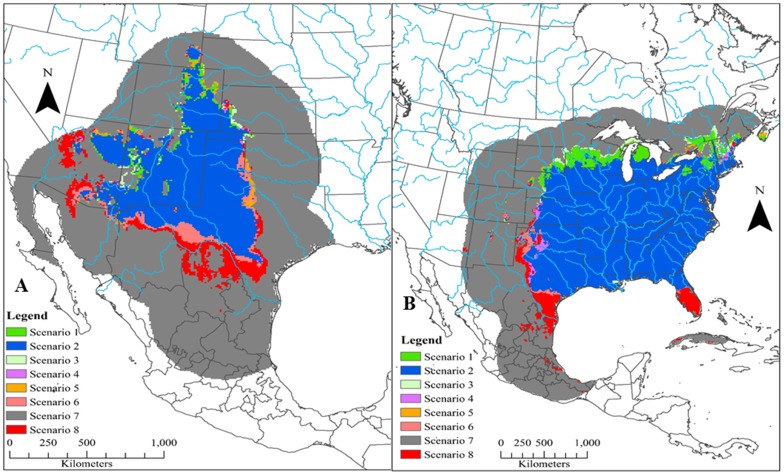
Future predicted changes in distributions of scaled quail (Callipepla squamata; a) and northern bobwhite (Colinus virginianus; b) projected to 2070 and based on ensemble forecasts (as estimated through Maxent) at 90% agreement.Major rivers of North America (blue lines) are included for geographic reference. Full descriptions for possible distribution conditions are given in Table 2. In short, distribution conditions represent: condition 1 (distribution expansion from current to 2050 and remaining suitable from 2050 to 2070), condition 2 (suitable at current and through all time periods), condition 3 (unsuitable from current to 2050 but expanding from 2050 to 2070), condition 4 (distribution contraction from current to 2050 but expanding from 2050 to 2070), condition 5 (distribution expansion from current to 2050 but contracting from 2050 to 2070), condition 6 (suitable from current to 2050 but contracting from 2050 to 2070), condition 7 (unsuitable at current and through all time periods), and condition 8 (distribution contraction from current to 2050 and remaining unsuitable from 2050 to 2070).